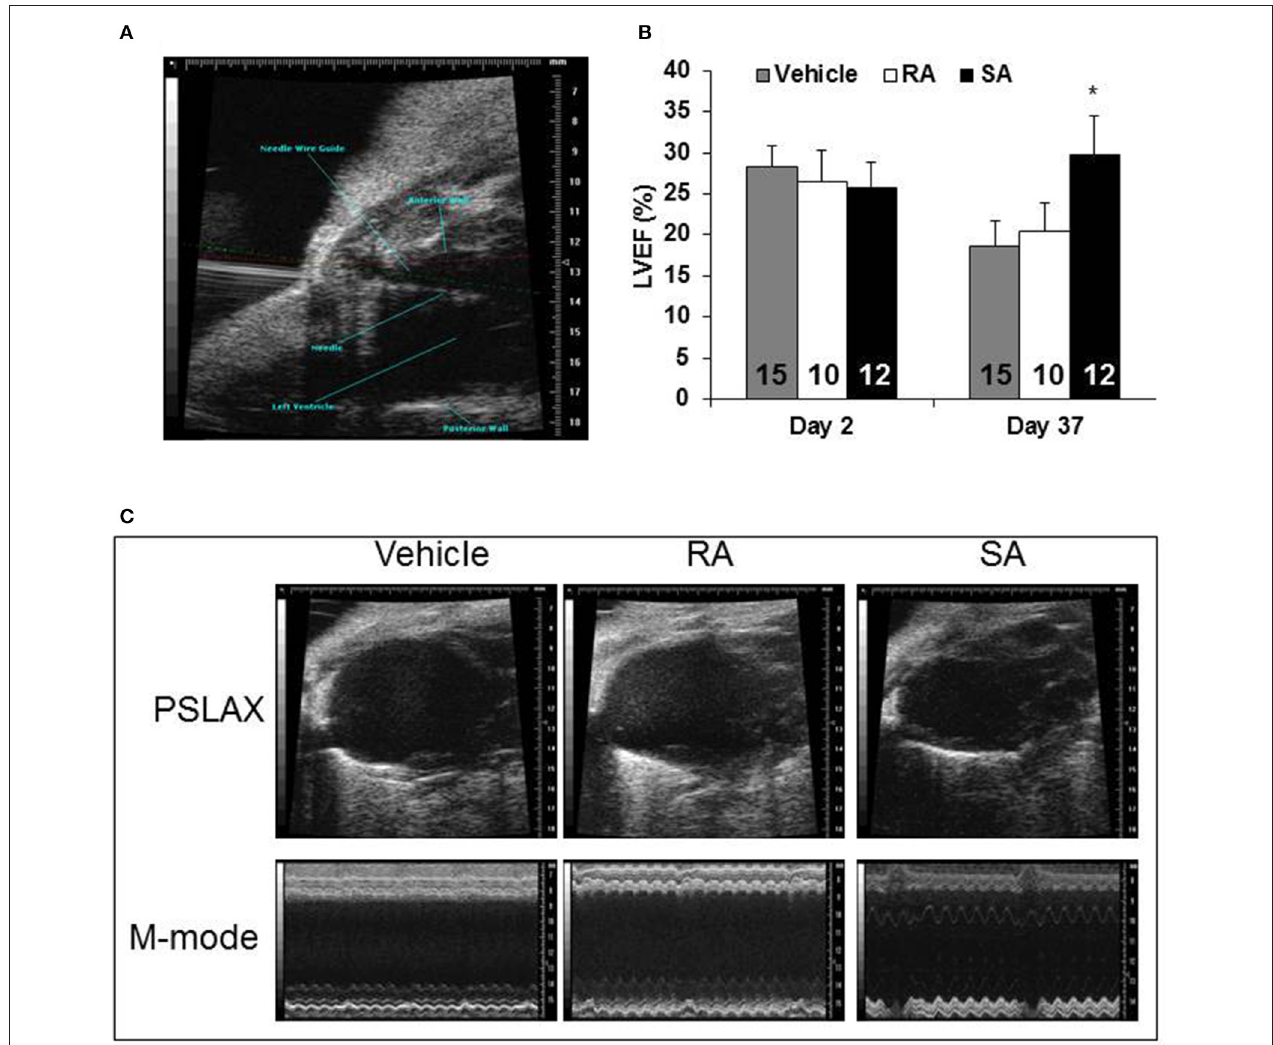
FIGURE 4 | Cardiac function 37 days after MI. Two days following myocardial infarction, vehicle, RA c-kit pos CMCs, or SA c-kit pos cMSCs, were percutaneously injected with echocardiographic guidance into the lumen of the left ventricular cavity (A) . Echocardiography was used to determine diastolic and systolic volumes; the resulting ejection fractions are shown in (B) . Representative frames from B-mode imaging (labeled PSLAX) and M-mode imaging are shown for the three groups in (C) . Values are mean ± SD. * p < 0.05 vs.